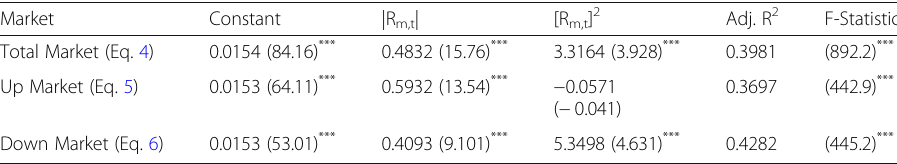
Table 3 Herding behavior during up and down market Market Constant |R m,t | [R m,t ] 2 Adj. R 2 F-Statistic Total Market (Eq. 4) 0.0154 (84.16) *** 0.4832 (15.76) *** 3.3164 (3.928) *** 0.3981 (892.2) *** Up Market (Eq. 5) 0.0153 (64.11) *** Down Market (Eq.